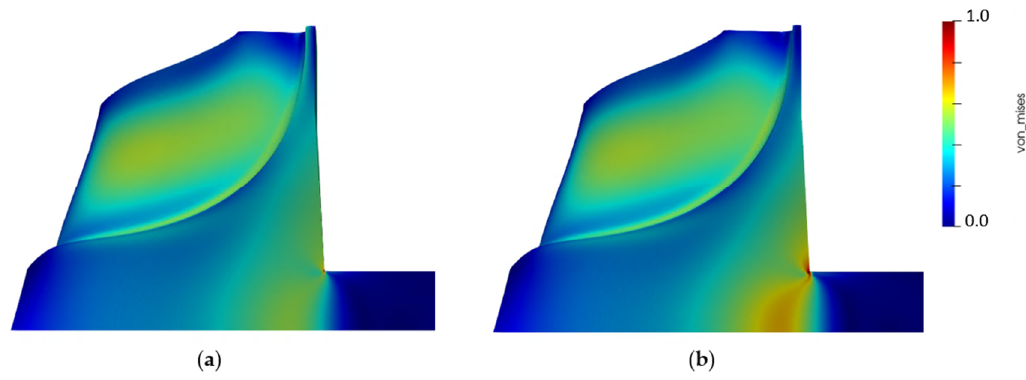
Figure 21. Normalized von Mises stresses pattern comparison in baseline layout: ( a ) mechanical versus ( b ) thermo-mechanical.